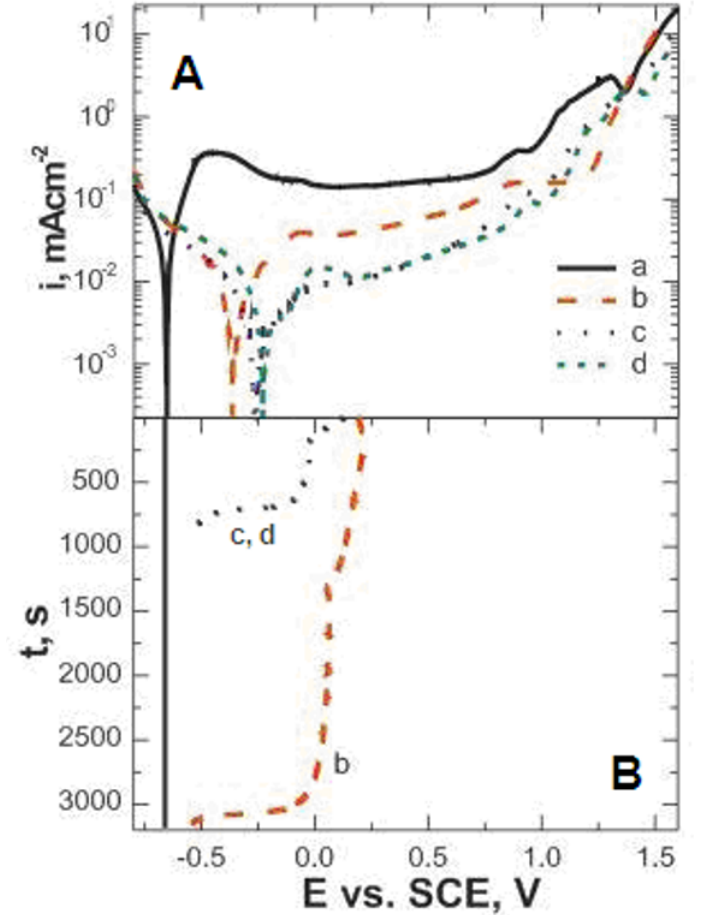
Figure 10. (A) Potentiodynamic curves recorded for bare stainless steel (a), and for stainless steel covered with 4-ABA/K and 4-ABA film (c, d) in electrochemical deposition process by using cyclic voltammetry (b, c) and chronopotentiometry (d). (B) Changes of open circuit potentials vs. exposure time. Electrolyte: 0.25 mol dm -3 K